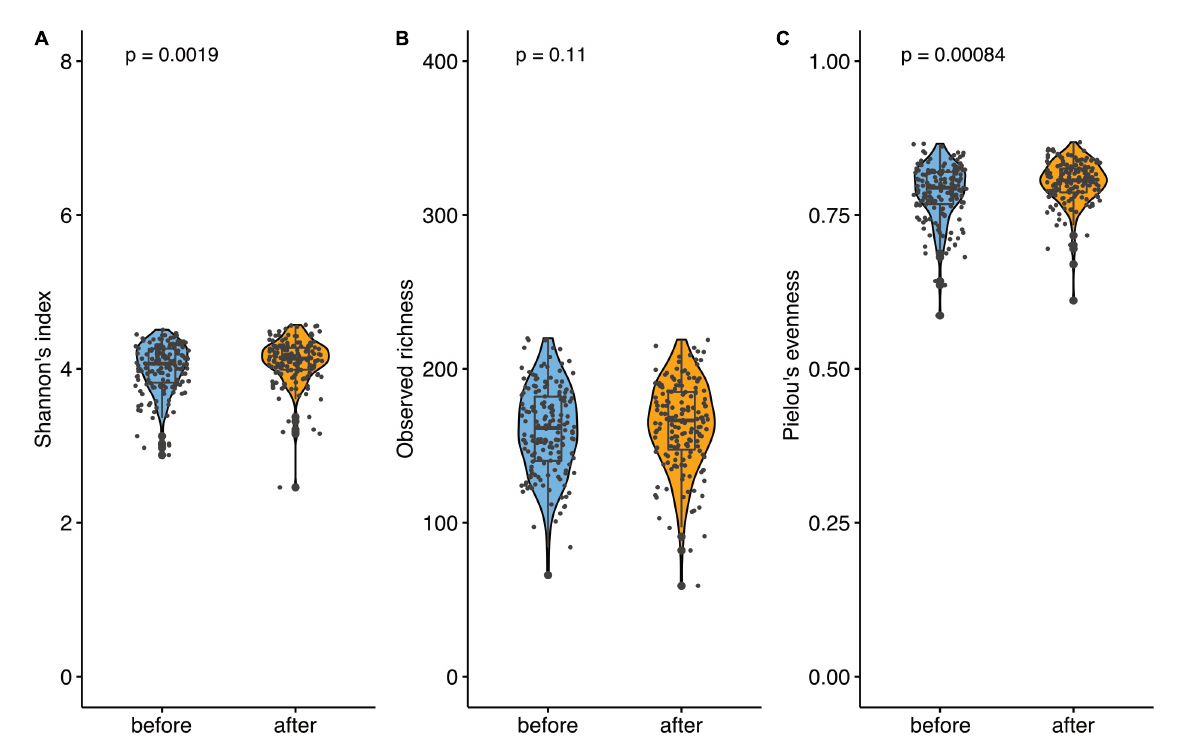
FIGURE4 Microbiome analysis before and after the supplementation. (A) Comparison of alpha diversity. Alpha diversity was estimated using Shannon’s index. (B) Comparison of observed richness and (C) Pielou’s evenness. Data are presented as individual data points (dots); median and interquartile ranges are shown as boxplots; p-values were estimated using Wilcoxon test.